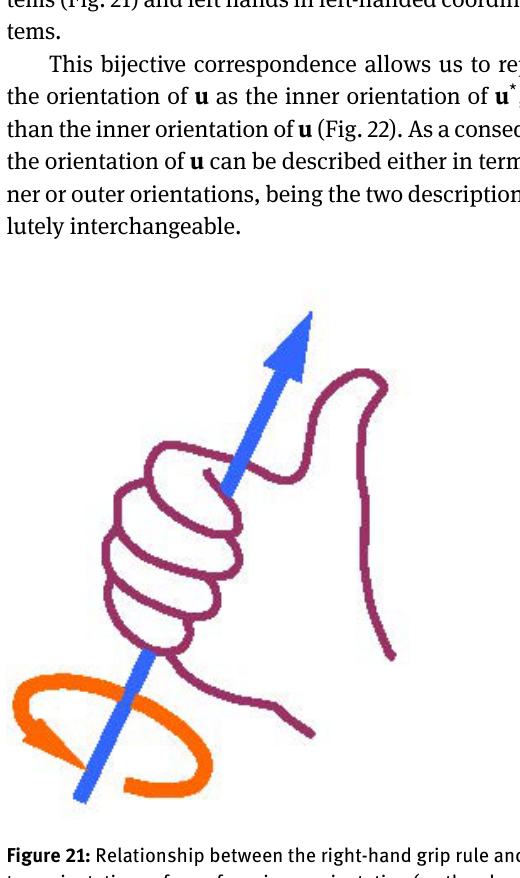
Figure 21: Relationship between the right-hand grip rule and the two orientations of a surface: inner orientation (on the plane on which the right fist is) and outer orientation (along the direction of the thumb). The figure also provides the two orientations of a vector: inner orientation (along the direction of the thumb) and outer orientation (on the plane on which the right fist is).